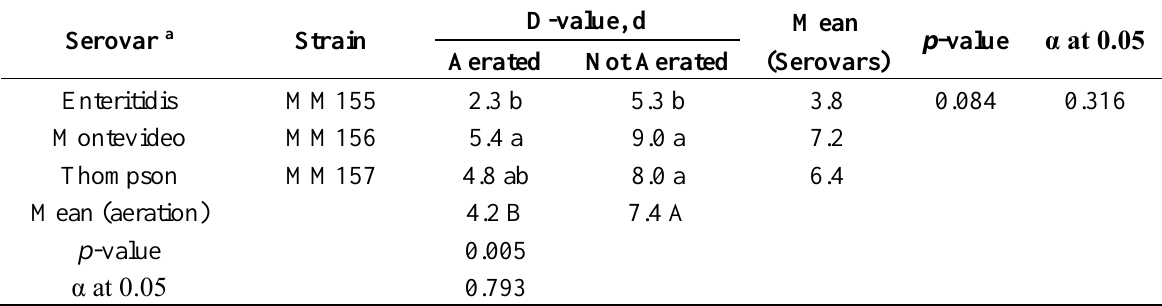
Table 4. Influence of aeration on survival of Salmonella enterica in dairy wastewater.